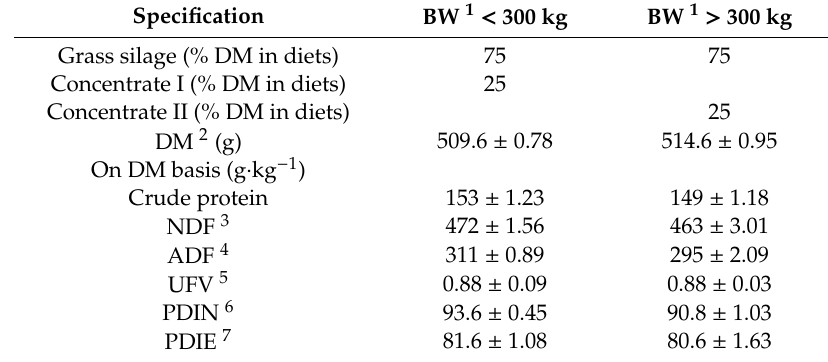
Table 2. Chemical composition and nutritional value of experimental total mixed rations (mean ± standard error of the